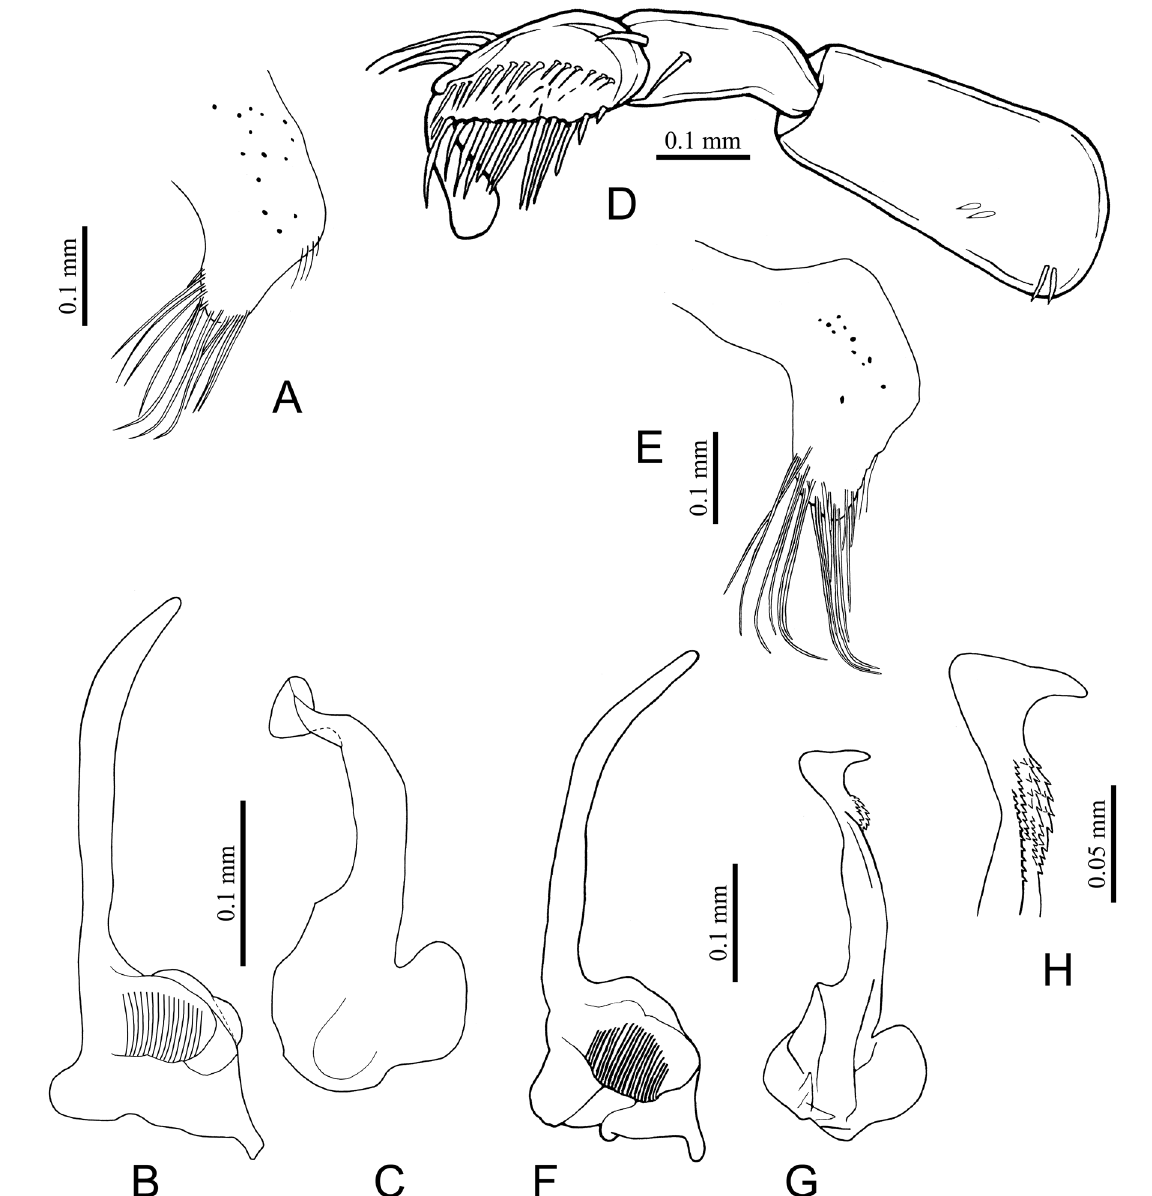
Fig. 22. Morphological features of species of Micronecta Kirkaldy, 1897, ♂♂. A–C . M. quadristrigata Breddin, 1905 (ZVNU). D–H . M. altera Wróblewski, 1972 (ZVNU). A, E = free lobe; B, F = right paramere; C, G = left paramere; D = fore leg; H = apical part of left